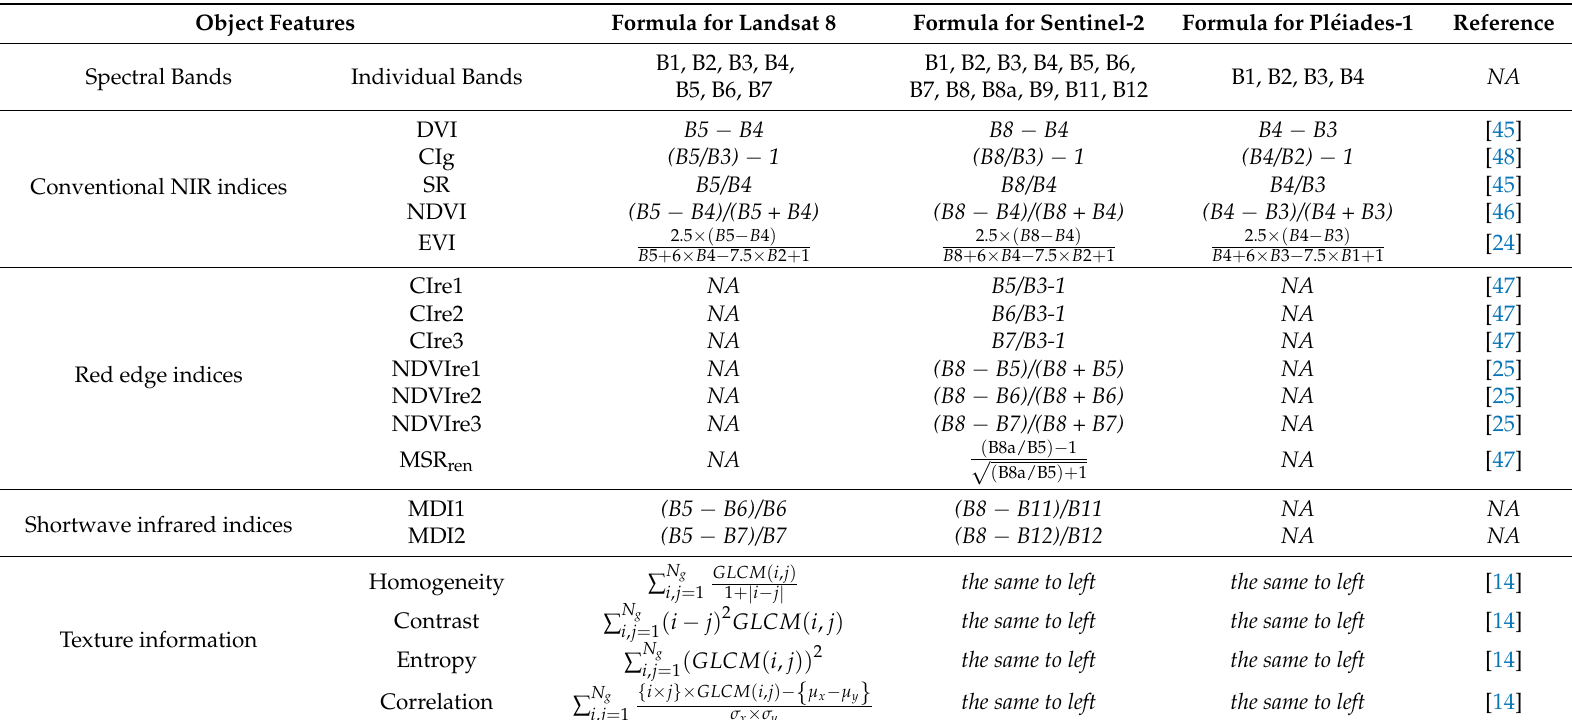
Table 4. A list of object features for mangrove species